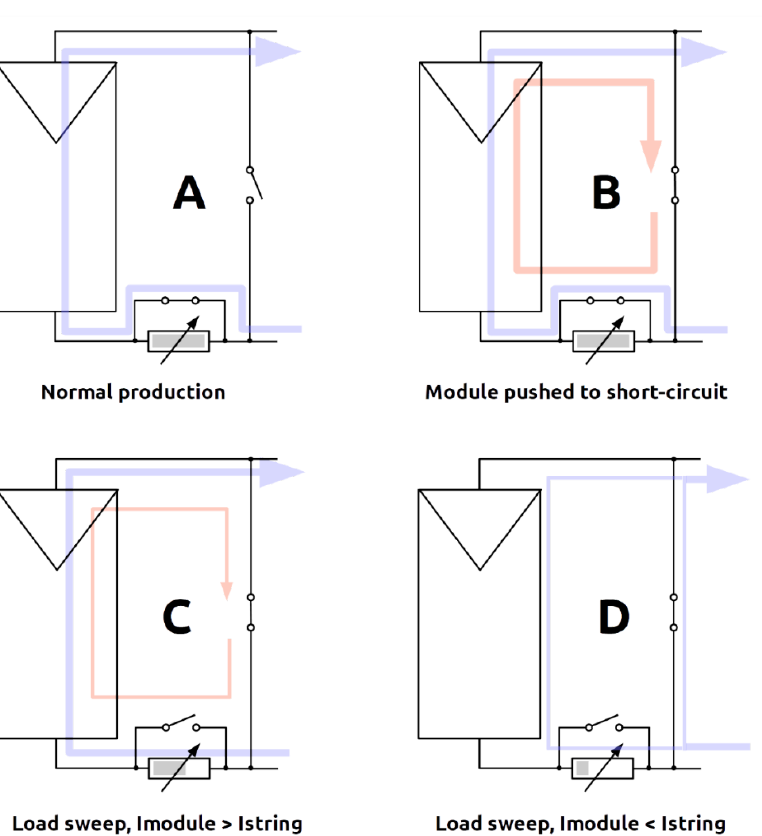
Figure 5. Current distribution during a current–voltage (I-V) sweep.